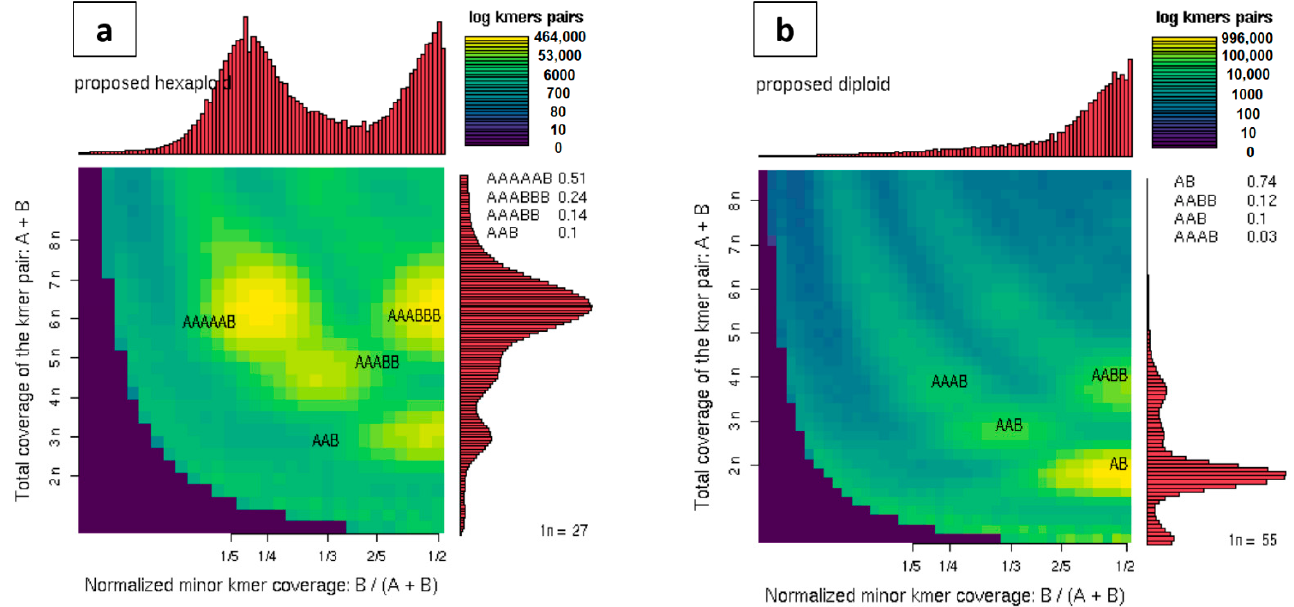
Figure 8. Two-dimensional heat maps were constructed to depict the prediction of ploidy from clean reads using Smudgeplot (k = 21). ( a ) Reseda lutea and ( b ) Reseda pentagyna . The color intensity corresponds to the approximate amount of k-mers per bin, ranging from purple (weak) to yellow (strong). Estimated ploidies are shown in the upper left corner of each graph, with the likelihood of various ploidies shown on the right.